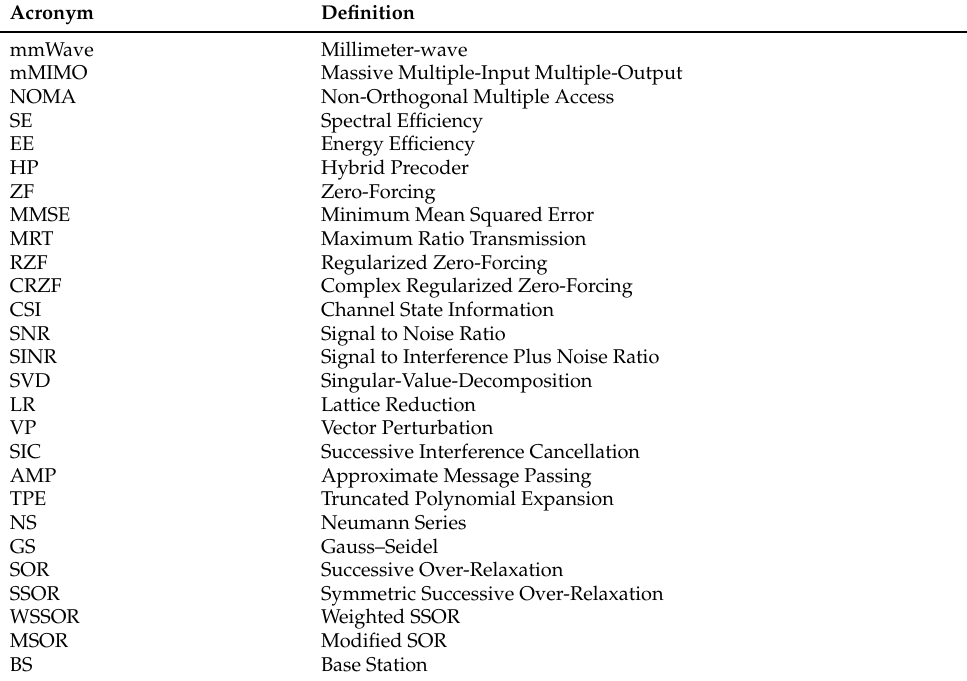
Table 1. List of acronyms and corresponding